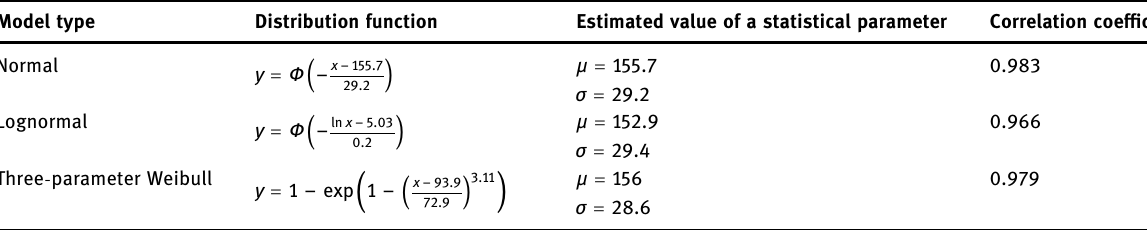
Table 2: Fitting functions of failure rate distribution of the tensile strength Model type